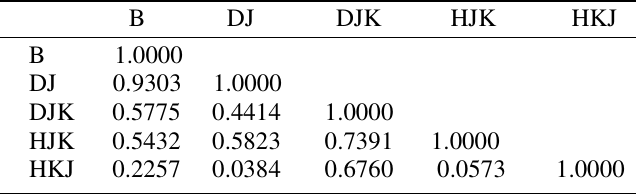
CN for the ground 3